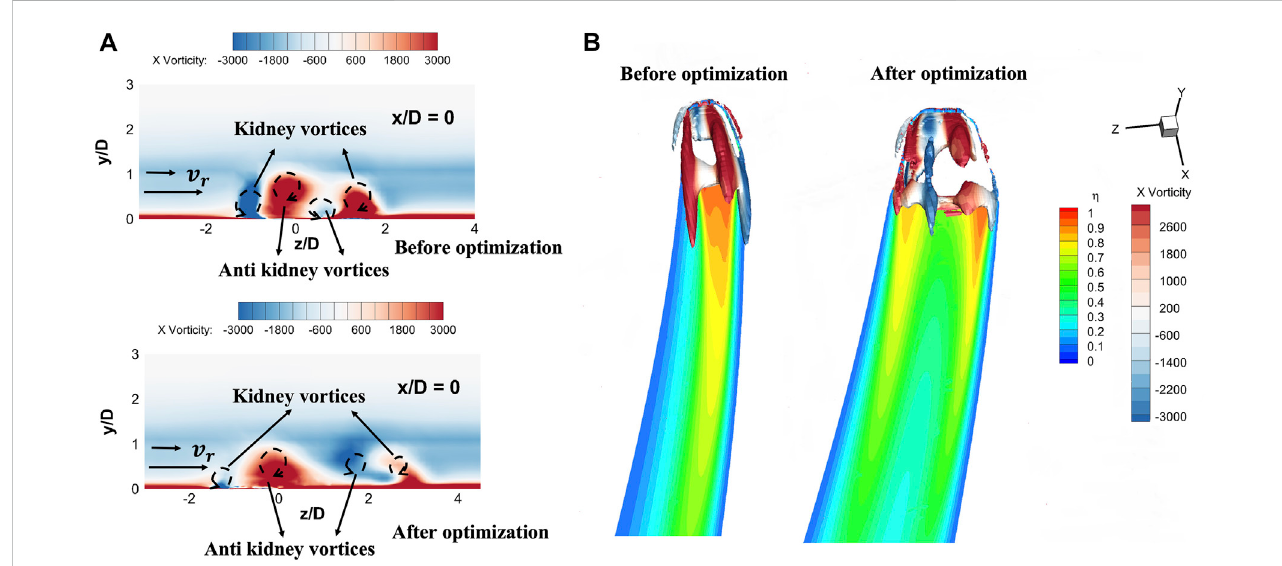
FIGURE 9 (A) Comparisonofx-directionvorticitydistributionattheholeexitbeforeandafteroptimization. (B) Comparisonofthevortexstructureby Q criteriawith Q = 1.7 Å (cid:5) 10 6 before and after optimization.